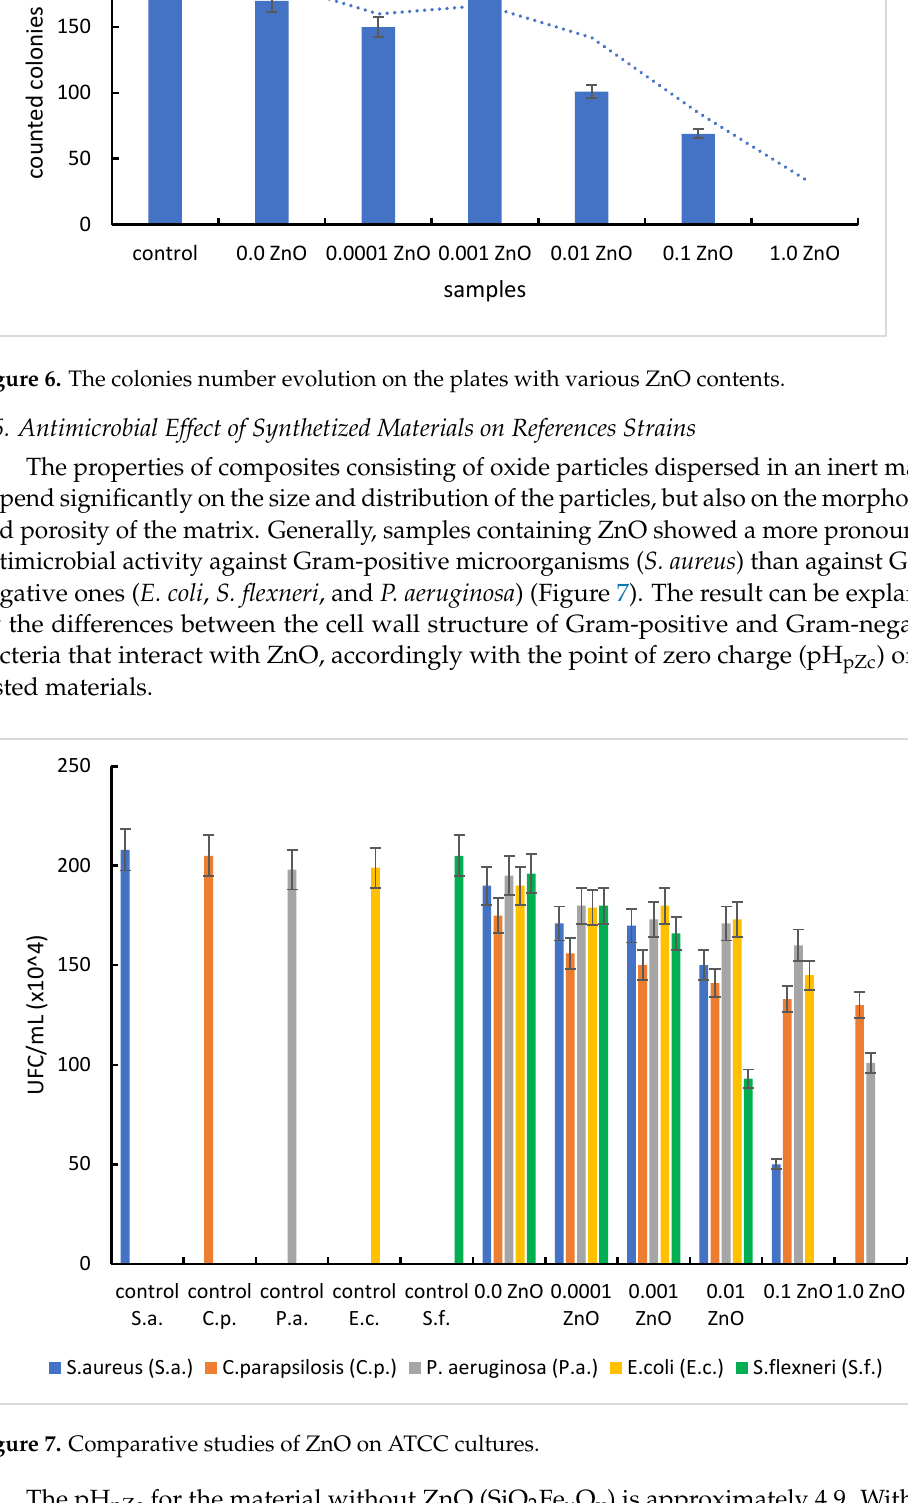
Figure 7. Comparative studies of ZnO on ATCC cultures. The pH pZc for the material without ZnO (SiO 2 Fe x O y ) is approximately 4.9. With the